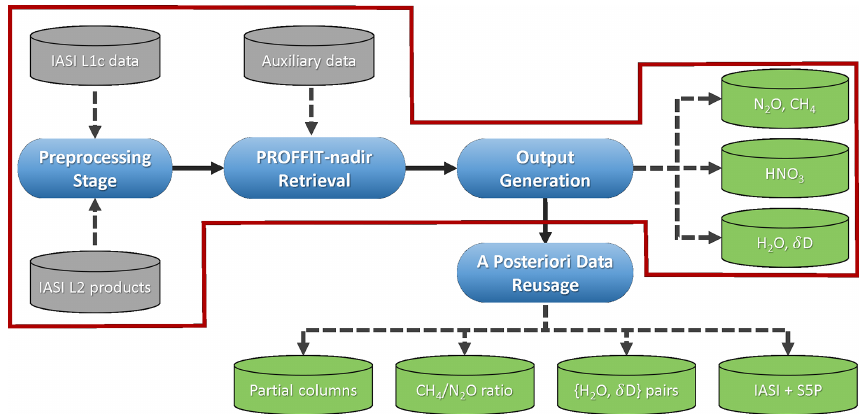
Figure 1. Outline of the MUSICA IASI processing chain. This paper focuses on the processing steps as indicated by the red frame. The green symbols indicate different products. The supply of detailed information on retrieval settings and product characteristics offers many different possibilities for a posteriori processing and date reusage as indicated at the bottom of the schematics and discussed in Sect. 8 (S5P here means the main sensor on the Sentinel-5 Precursor